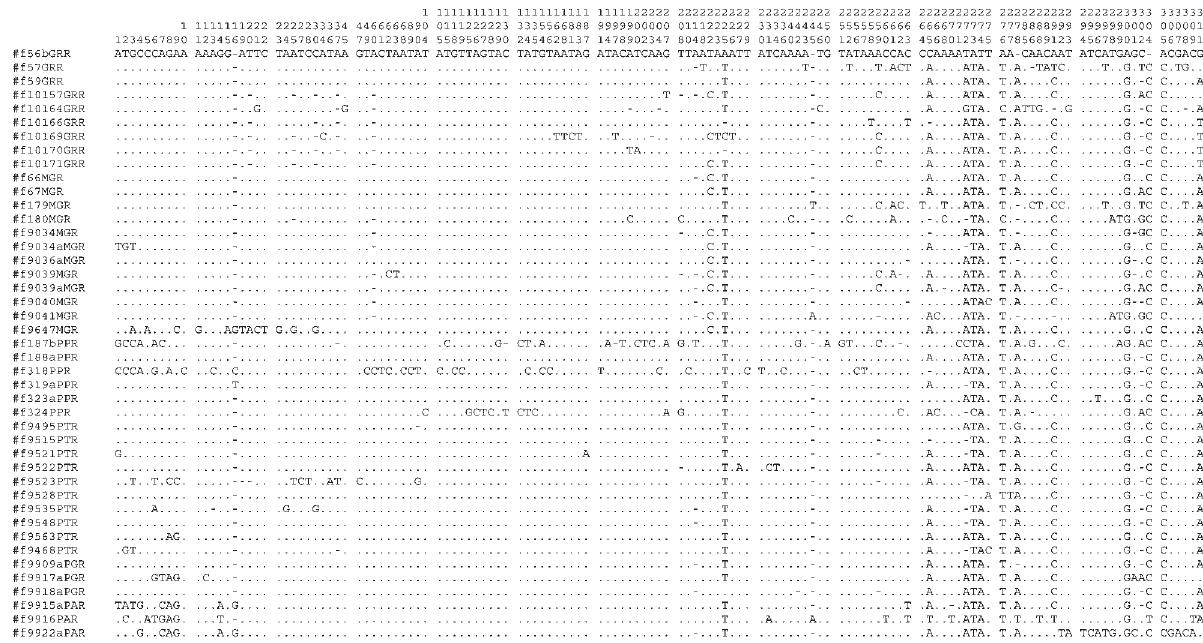
Figure 3 - Nucleotide sequence alignment of the observed variable sites in the D-loop 5’-region of 43 Leporinus elongatus individuals sampled from dis- tinct populations from Grande River (GRR), Mogi-Guaçu River (MGR), Paranapanema River (PPR), Piracicaba/Tietê Rivers (PTR), Paraná River- Guaíra (PGR), and Paraná River-Ayolas (PAR). Hyphens indicate gaps and dots represent nucleotide identity.